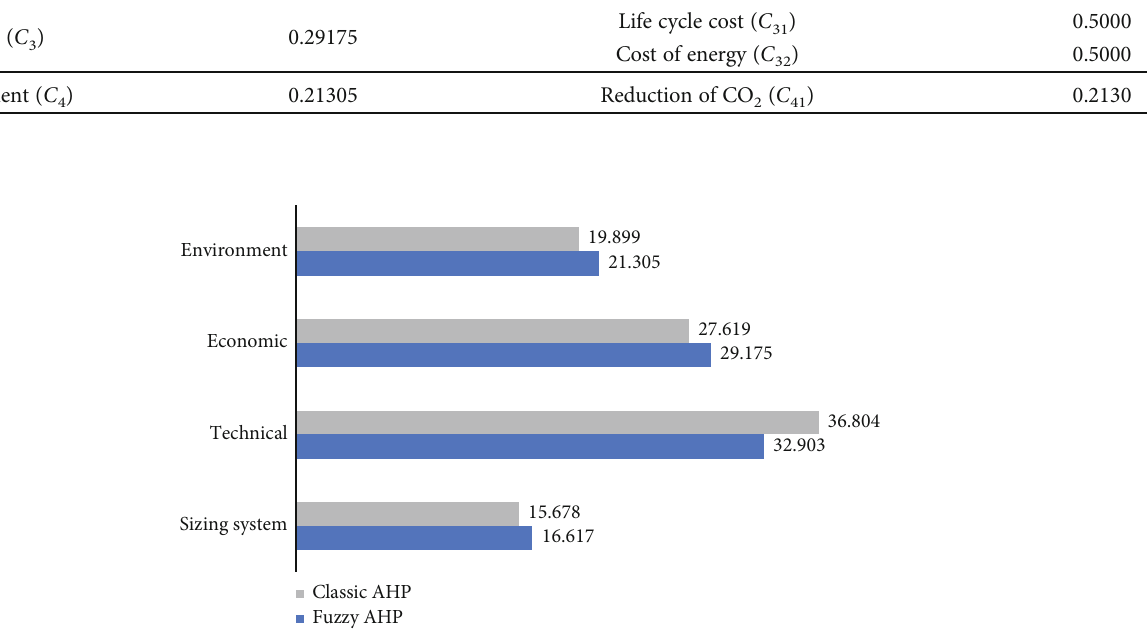
Figure 9: Priority weight of